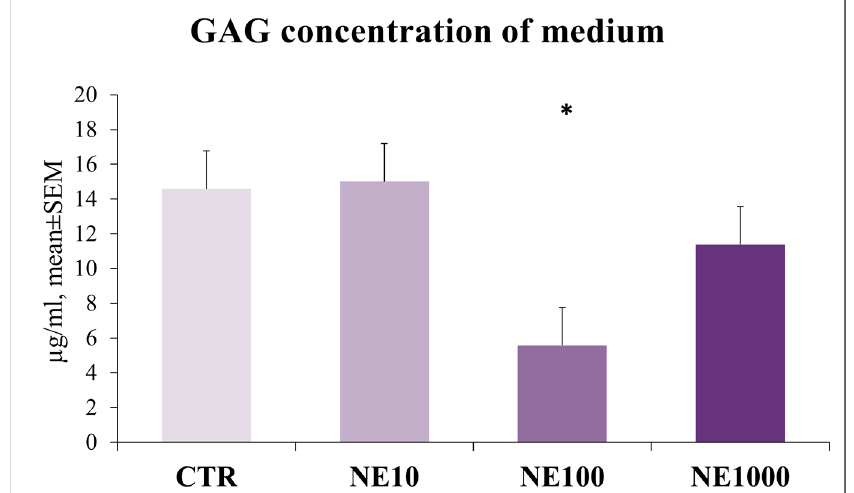
Figure 10. Glycosaminoglycan (GAG) concentration of culture medium after 1-h norepinephrine (NE) treatment. CTR = non-treated control cells, NE10 = 10 µM norepinephrine treated cells, NE100 = 100 µ M norepinephrine treated cells, NE1000 = 1000 µ M norepinephrine treated cells. n = 6/group, results are expressed as mean ± SEM, * p <